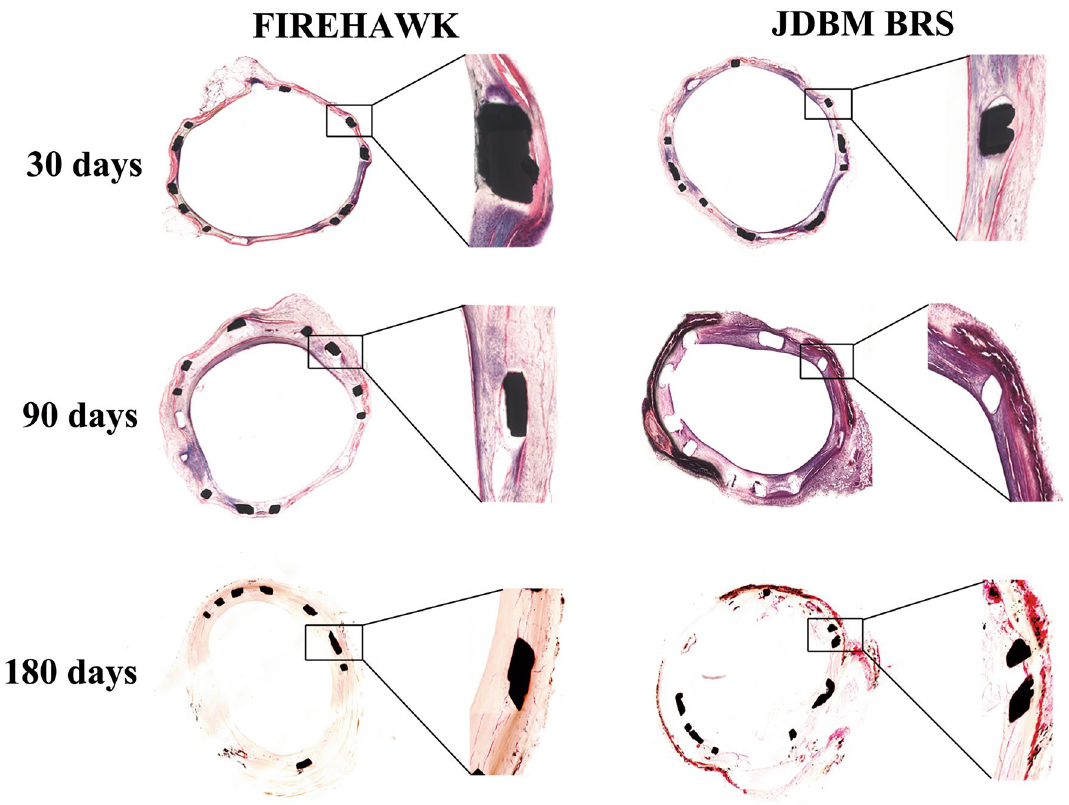
Figure 7. Representative histological images of JDBM BRS and FIREHAWK groups after implanted into porcine arteries for 30, 90, and 180 days. Sections are stained with